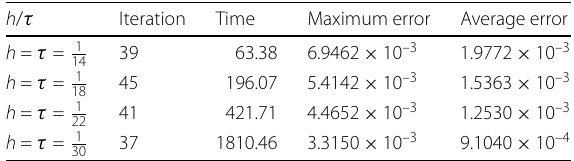
Table 10 The number of iterations, execution times (in sec) and errors of C–N high-order finite difference method for Test problem 2, when γ = 0.75 and ν = 0.5